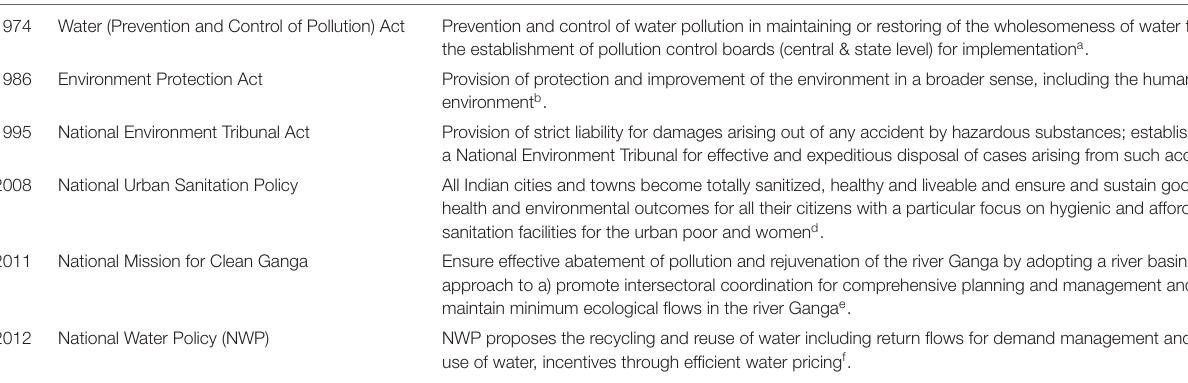
TABLE 3 | Overview of policies and acts in India for wastewater management.